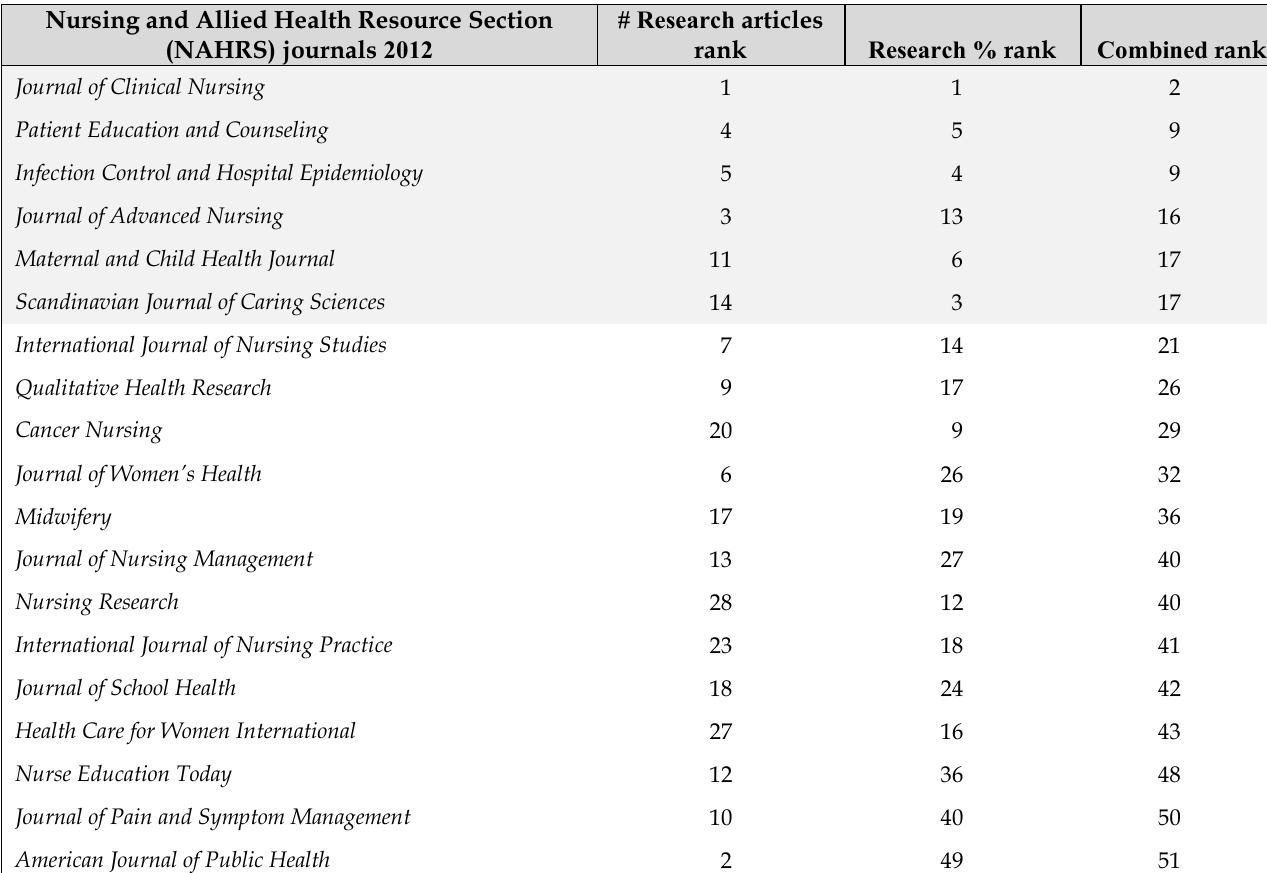
Table 1 Ranking of 2012 Nursing and Allied Health Resource Section (NAHRS) list of nursing journals Nursing and Allied Health Resource Section